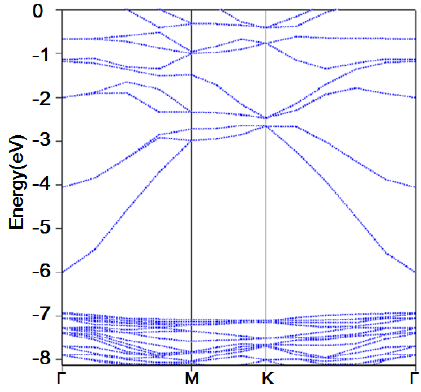
Figure 2. Band Structure of Bulk ZnSnO 3 .